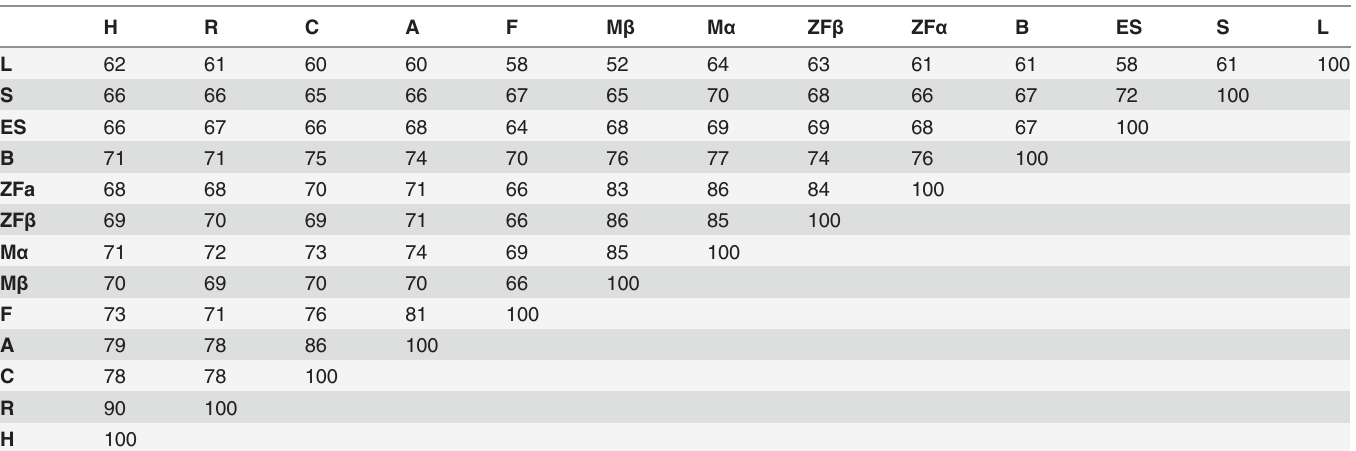
The numbers in the table correspond to percent sequence identity. Key: Lamprey (L), Skate (S), Elephant Shark (ES), Bichir (B), Zebra fi sh α (ZF α ), Zebra fi sh β (ZF β ), Medaka α (M α ), Medaka β (M β ), Frog (F), Alligator (A), Chicken (C), Rat (R), Human